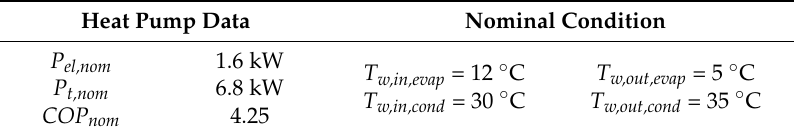
Table 9. Nominal data of the considered water-to-water heat